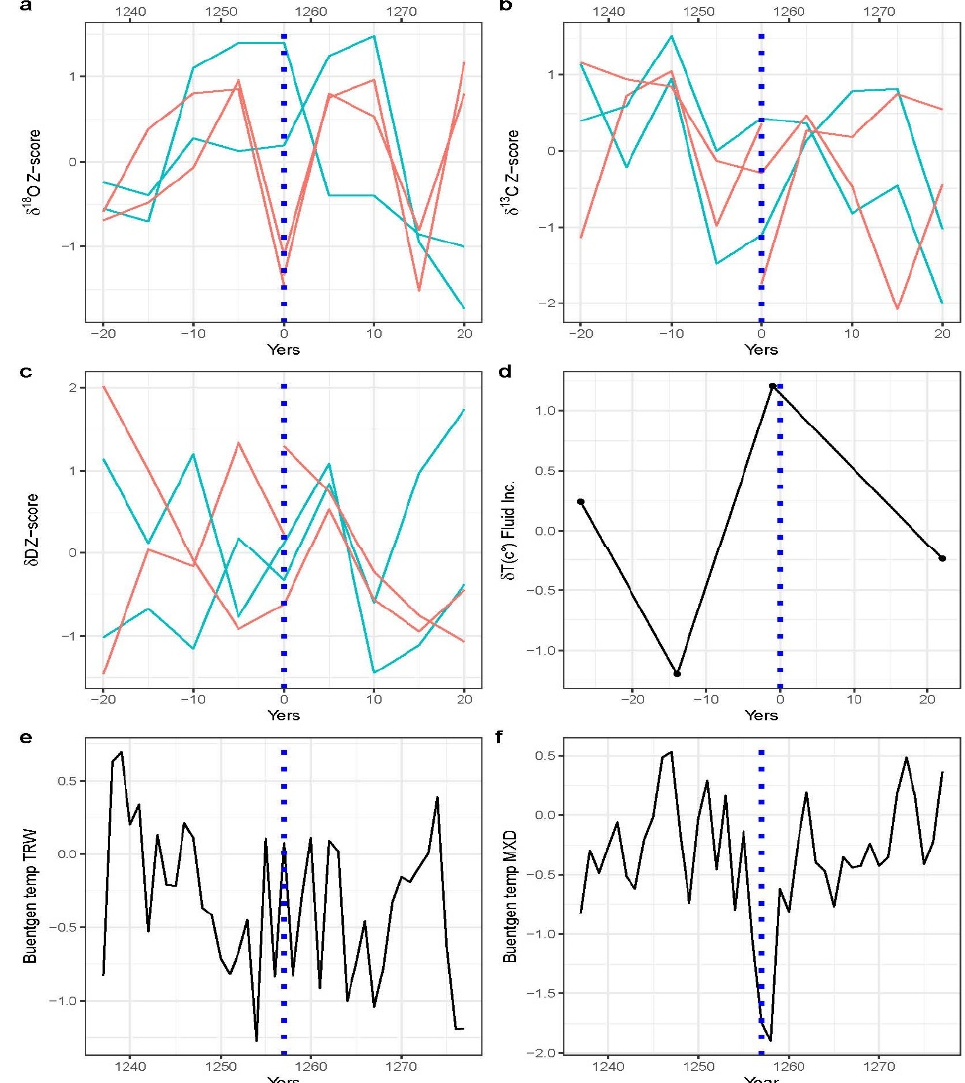
Figure 7. Plots of tree-ring cellulose isotopes and climate proxies in the period of the Samalas eruption, 1257 CE: ( a ) δ 18 O of two larch trees (orange) and of two cembran pines (blue) with 5-year resolution; the dotted vertical line indicates the eruption year. ( b ) δ 13 C of the trees from ( a ). ( c ) δ D of the trees from ( a ). ( d ) Temperature reconstruction from fluid inclusions from Milandre Cave. ( e ) The temperature reconstruction based on TRW by Büntgen et al., 2011. ( f ) The temperature reconstruction based on MXD by Büntgen et al.,